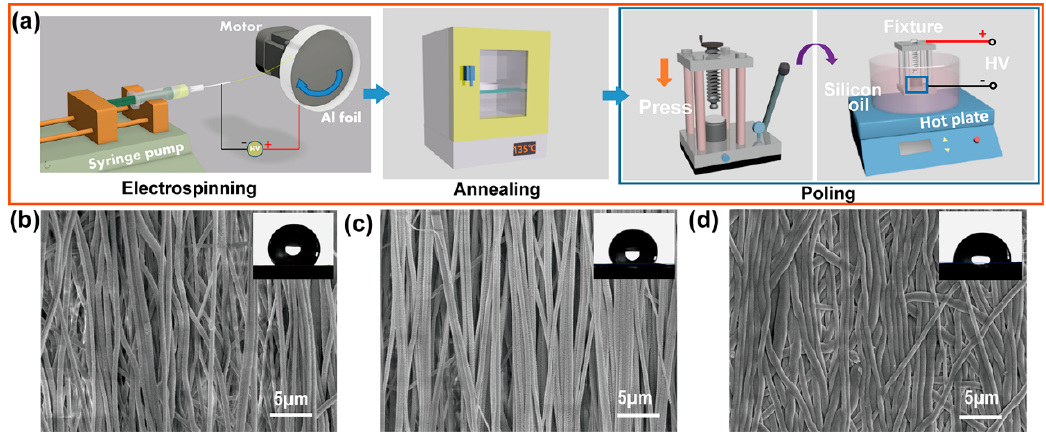
Figure 1. The morphology and contact angle of electrospun nanofiber membranes (NFMs). ( a ) Schematic illustration of the preparation and treatment of different samples. Scanning electron microscope (SEM) micrographs of ( b ) U-NFM, ( c ) A-NFM, and ( d ) P-NFM. The insets represent the contact angles corresponding to U-NFM, A-NFM, and P-NFM, respectively. (U-NFM represented pristine poly(vinylidene fluoride-trifluoroethylene)(P(VDF-TrFE)) NFM without any postprocessing; A-NFM represented annealed P(VDF-TrFE) NFM; P-NFM represented the poled samples.)